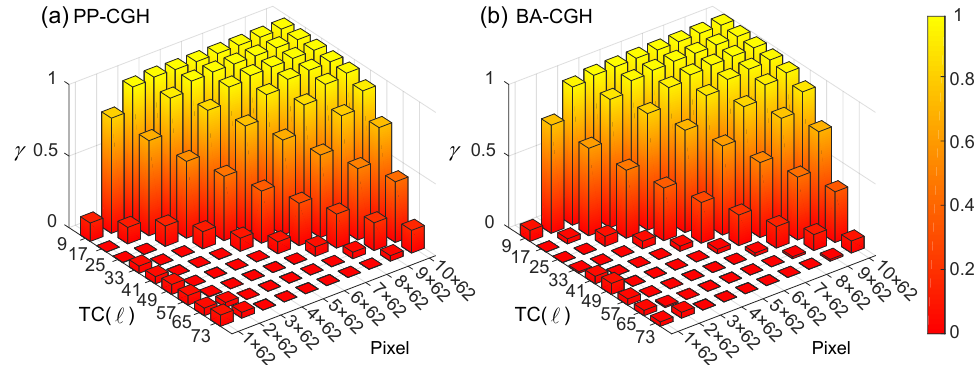
Figure 5. The complex amplitude correlation degree of vortex beam versus different TCs and different available pixel numbers for PP-CGH ( a ) and BA-CGH ( b